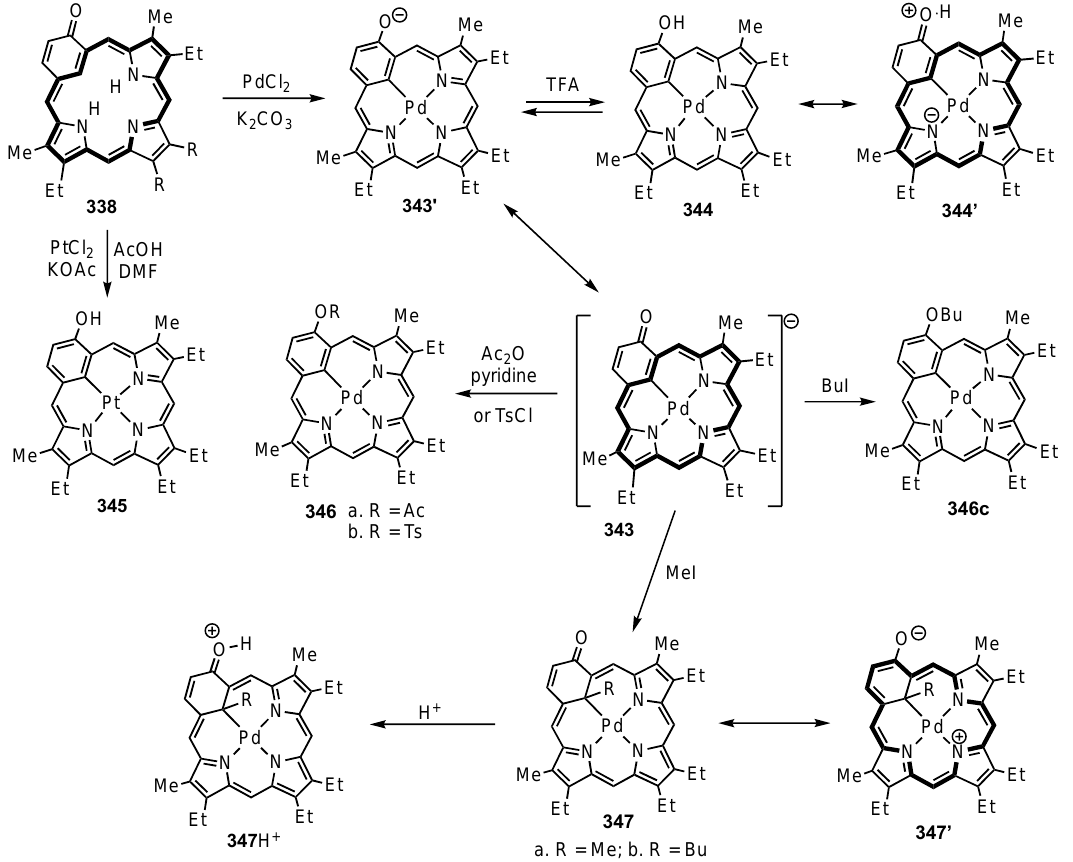
Scheme 56. Palladium(II) and platinum(II) complexes of oxybenziporphyrin.